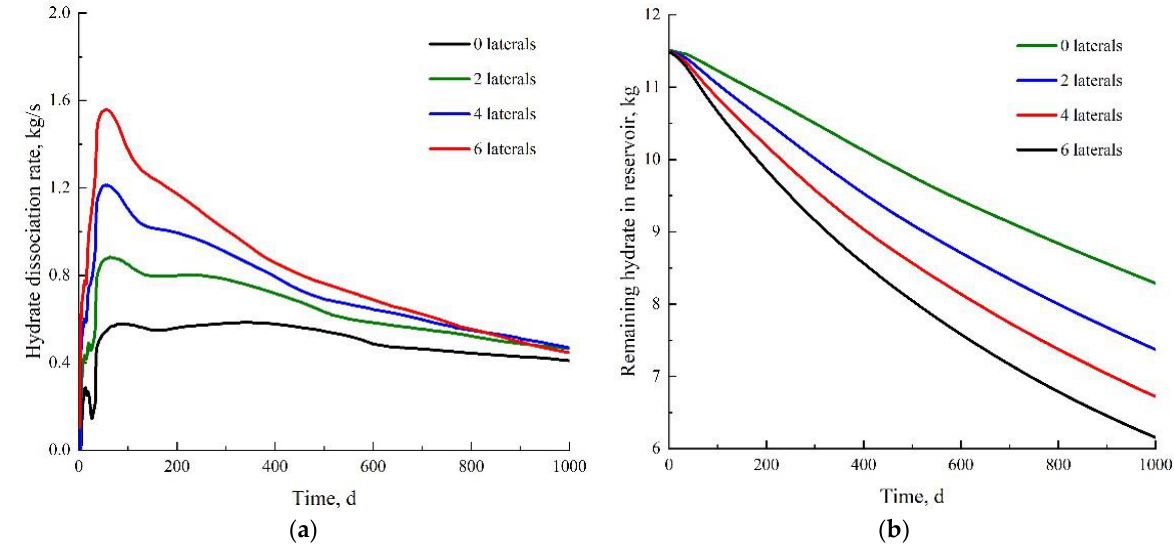
Figure 5. ( a ) Hydrate dissociation rate, ( b ) hydrate mass.